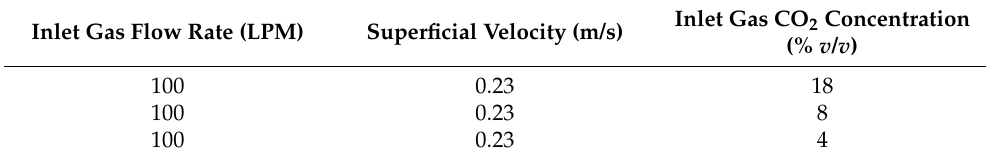
Table 1. Inlet flue gas flow rate conditions for cryogenic rig